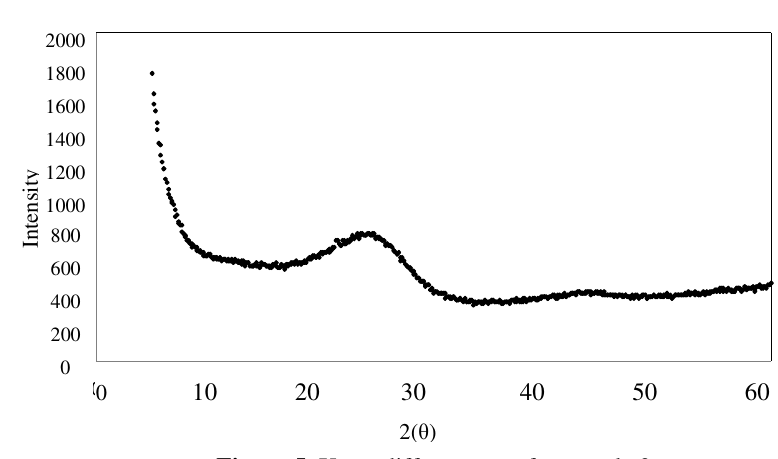
Figure 5 . X-ray diffractogram for sample 2.